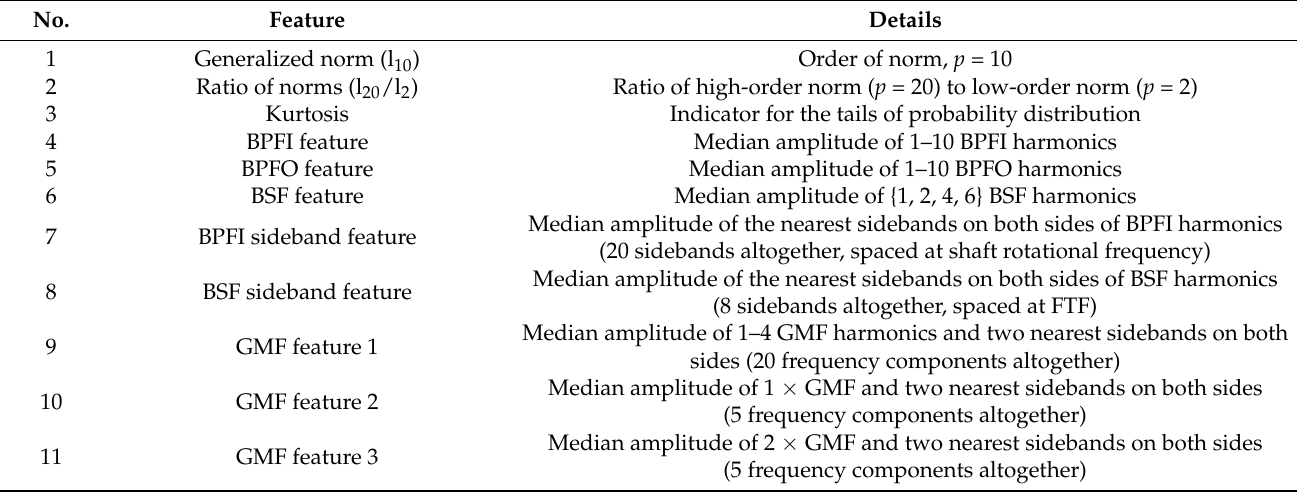
Figure 1. Flowchart for system identification with the position of ‘training subset selection’ high- lighted (adapted from [6]). Table 1. Description of features generated for condition